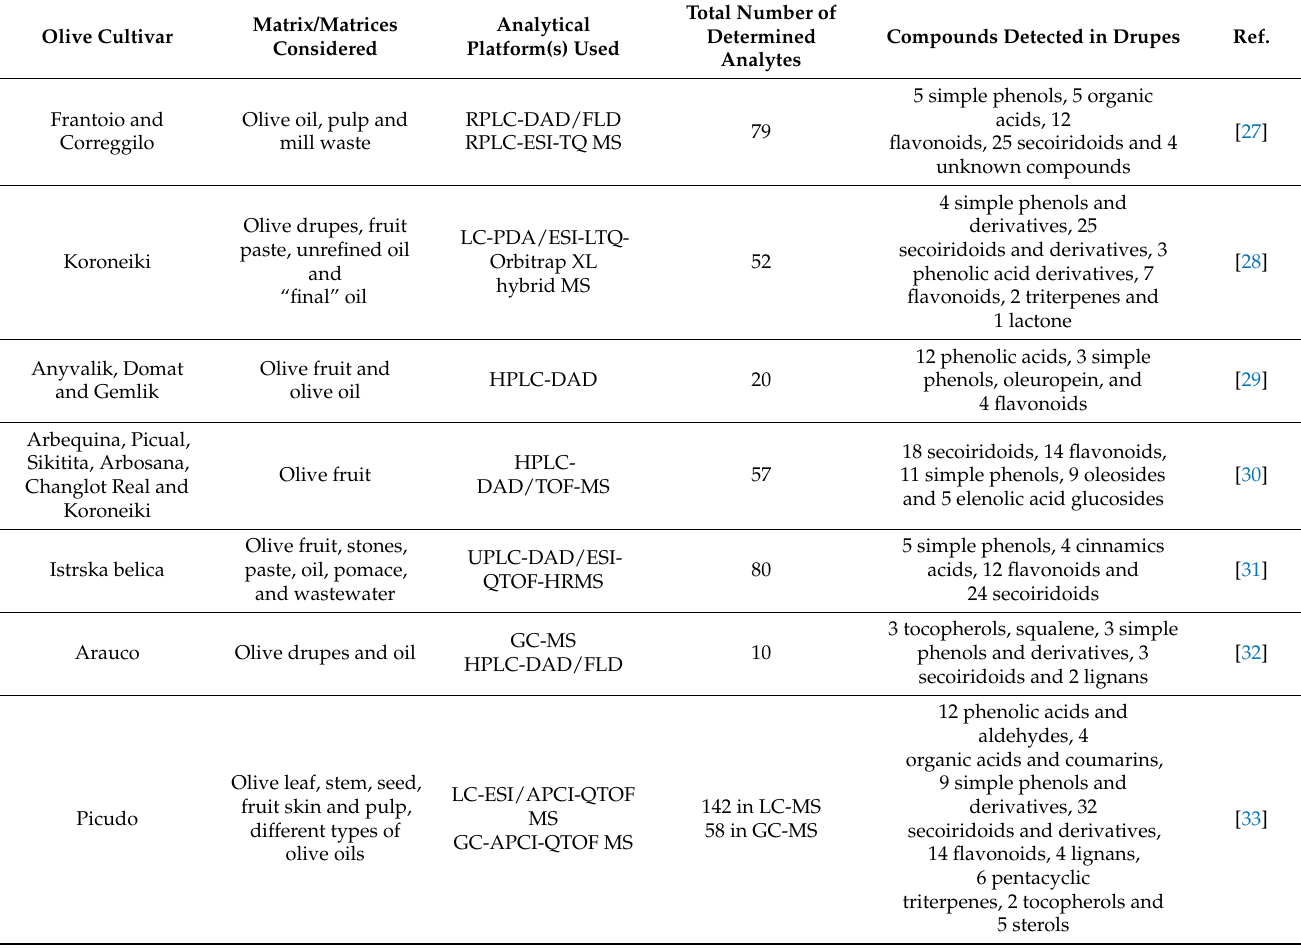
Table 1. Examples of comprehensive reports describing minor components of olive